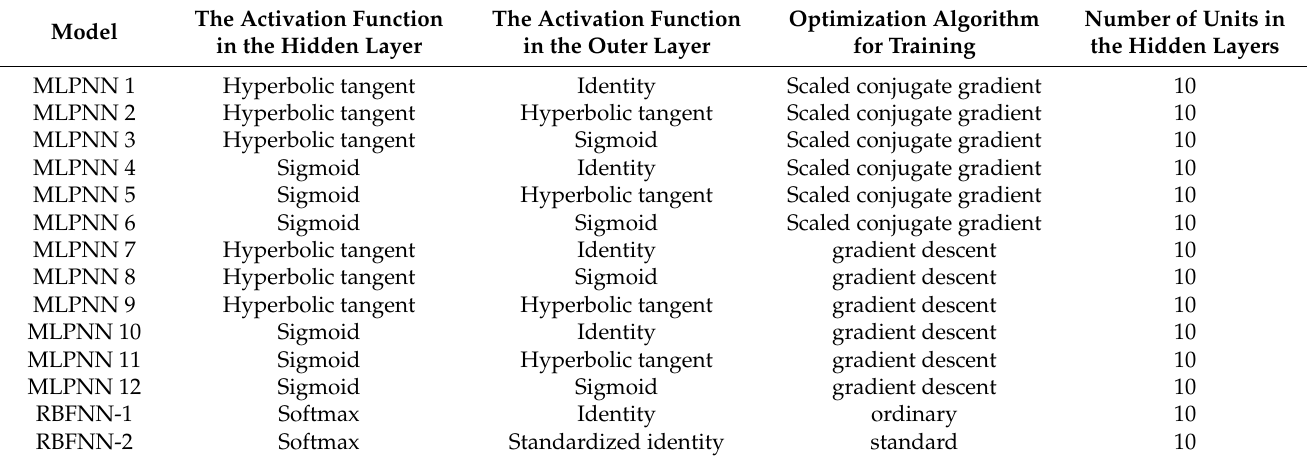
Table 1. Summary of the various MLPNN and RBFNN configurations